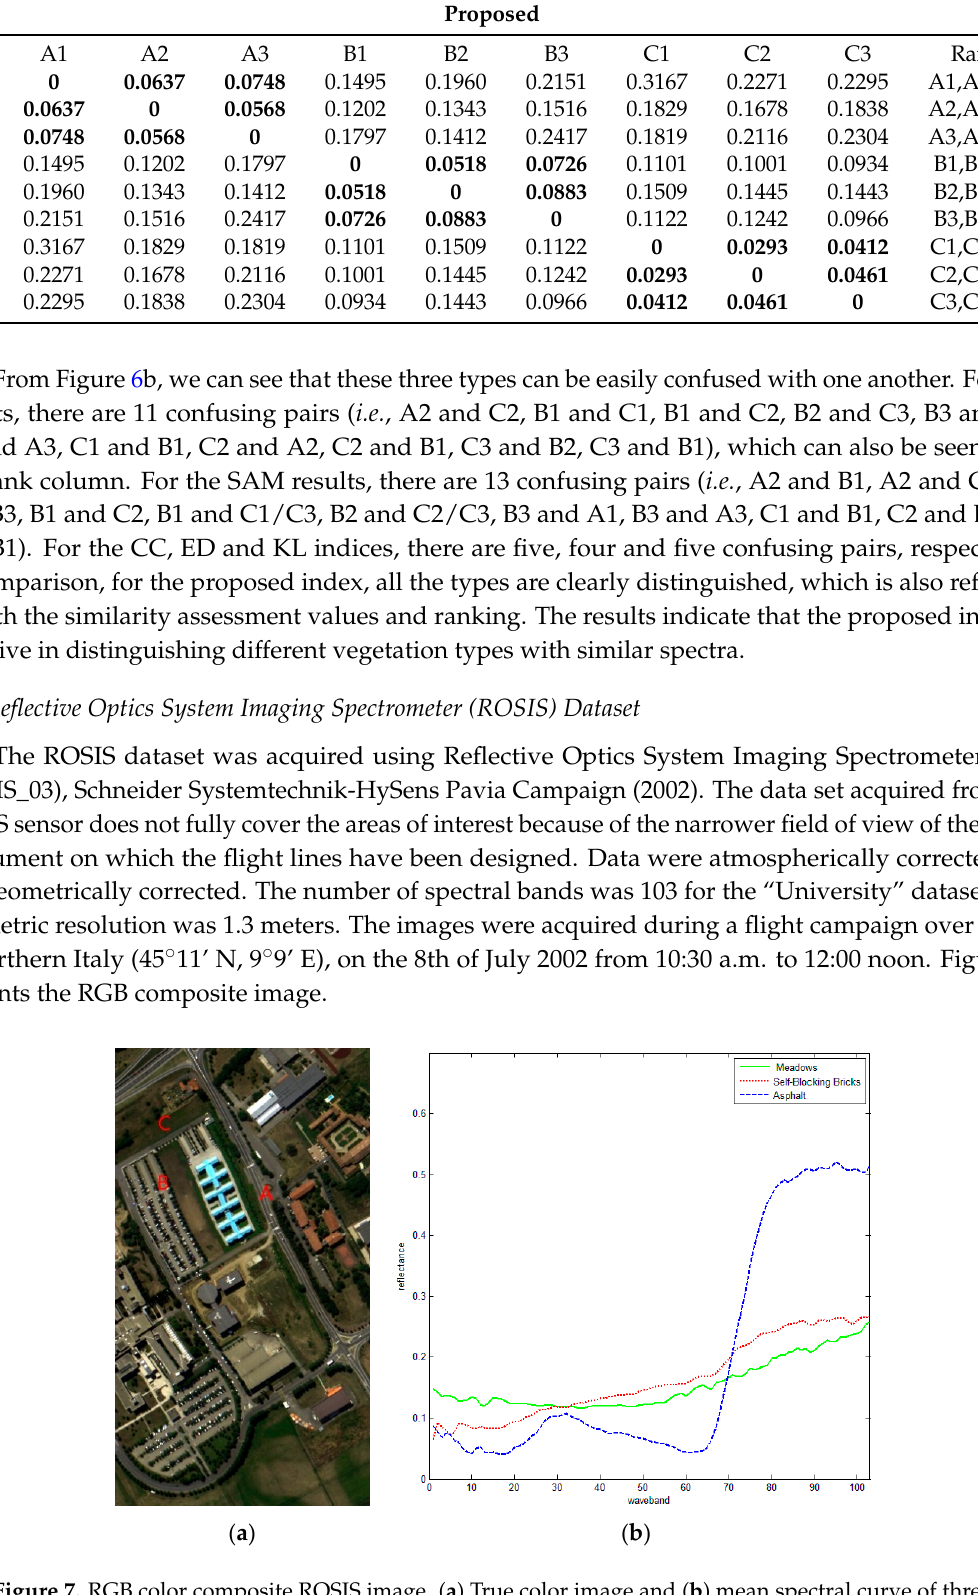
Figure 7. RGB color composite ROSIS image. ( a ) True color image and ( b ) mean spectral curve of three types of land cover.